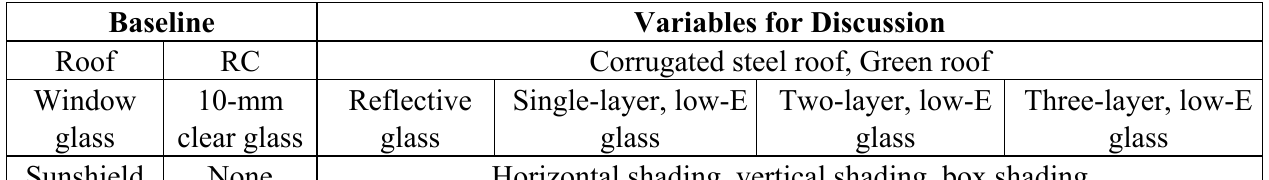
Table 4. Variables under